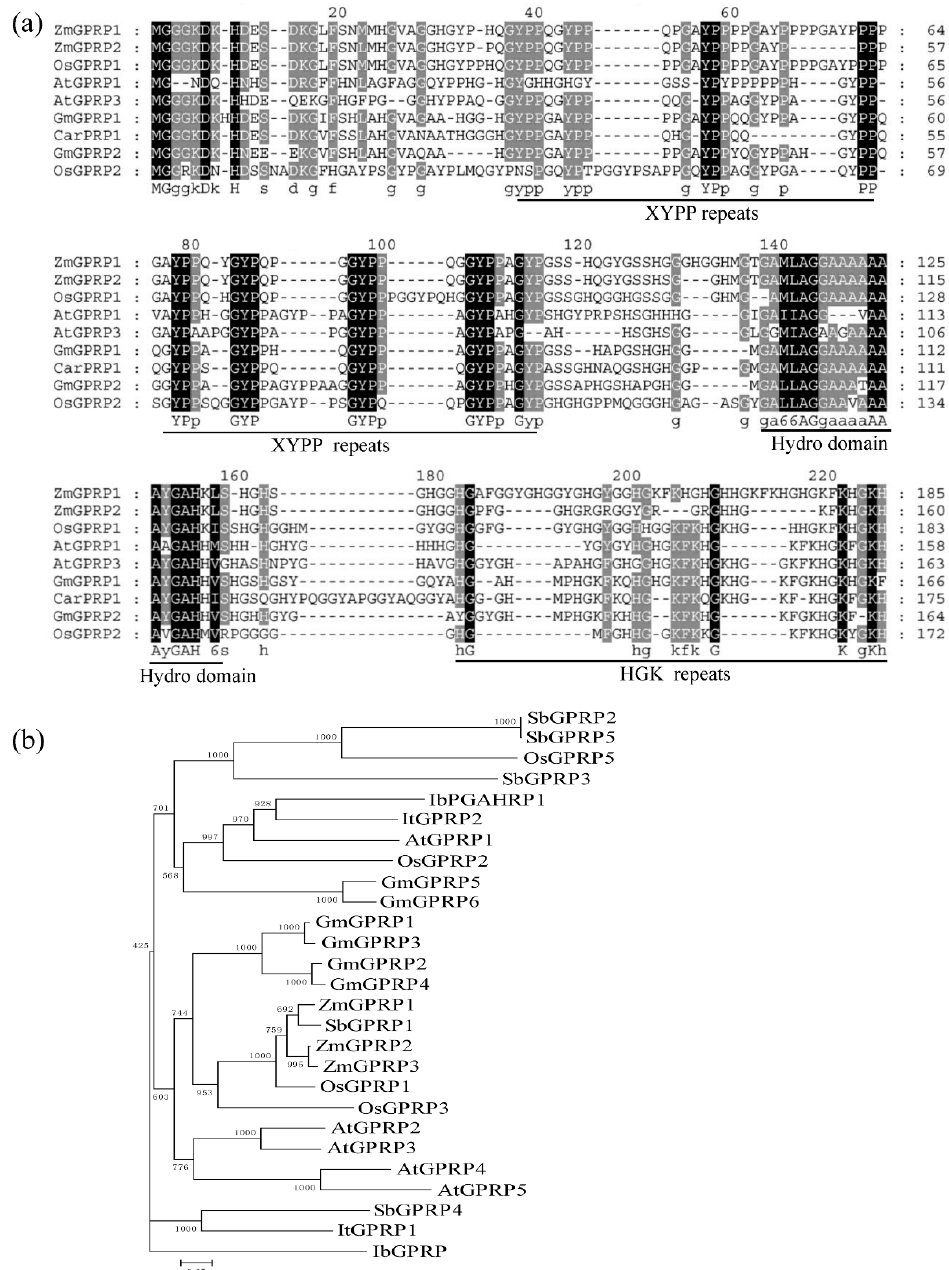
Figure 1. Multiple sequence alignment and phylogenetic analysis of glycine- and proline-rich proteins (GPRPs). ( a ) Multiple sequence alignment of GPRPs from different species. Identical amino acids are shaded in black, and similar amino acids are shaded in grey. ( b ) Phylogenetic tree of GPRPs from different species. Total of 22 GPRPs were identified from genomes of six species including Arabidopsis thaliana , Oryza sativa , Zea mays , Glycine max , Sorghum bicolor , Ipomoea batatas , and Ipomoea trifida used for the construction of the phylogenetic tree. Accession numbers of all GPRPs were presented in Table S1.